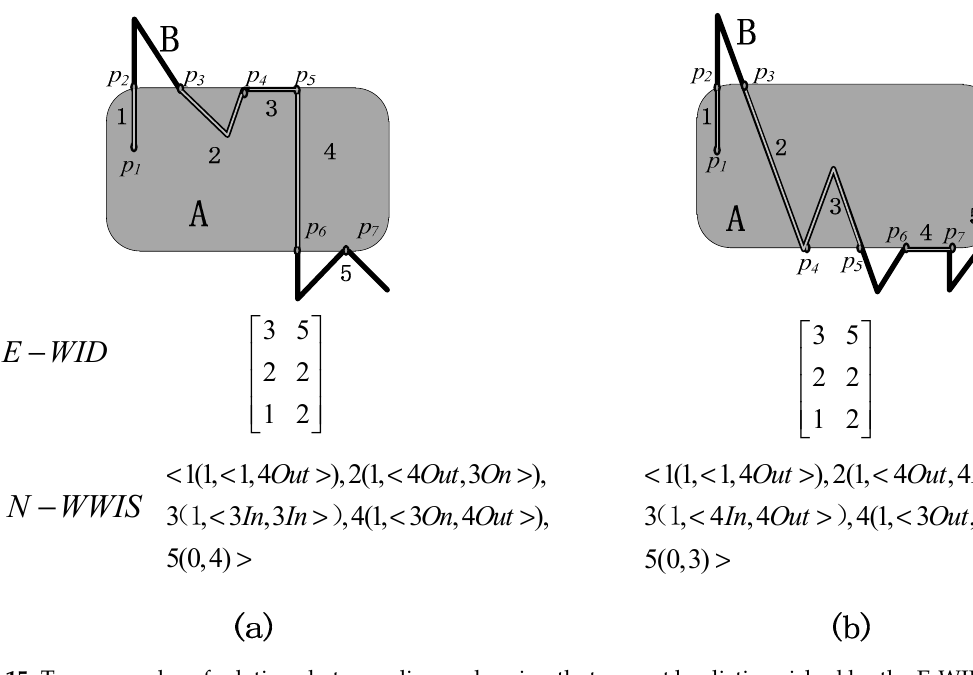
Figure 15. Two examples of relations between line and region that cannot be distinguished by the E-WID model but can be distinguished by the node degree-based whole-whole object intersection sets (N-WWIS) model. ( a ) One case that the intersection components between region A and line B are four intersection-lines and one intersection-point; ( b ) The other case that the intersection components between region A and line B are four intersection-lines and one intersection-point.